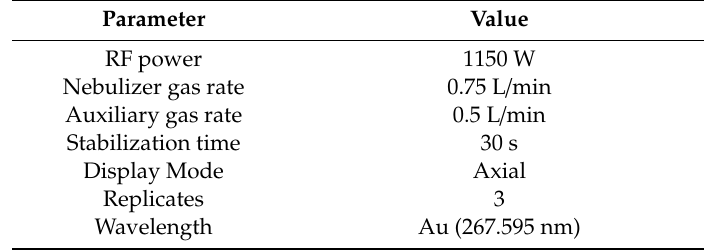
Table 1. Instrumental parameters used for elemental determination by ICP-OES.